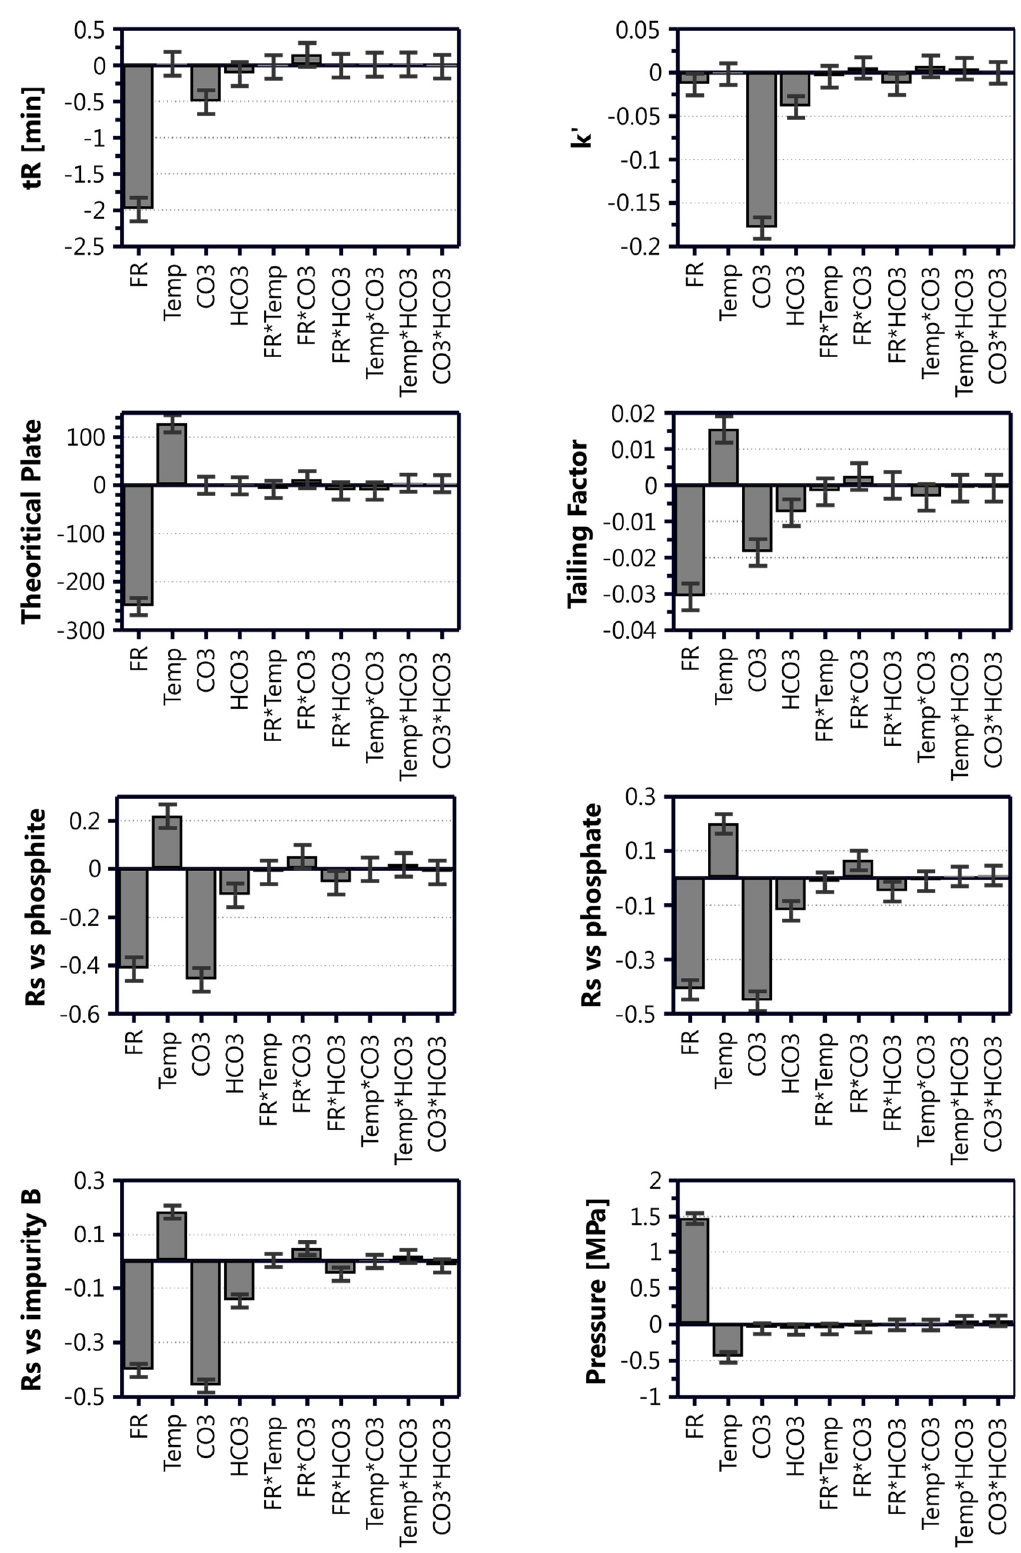
Figure 3. Coefficient plots for the full factorial design modeled around the provisionally optimum method conditions. The boxes indicate the relative impact of the coefficient on the model, while the whiskers show the uncertainty of the coefficient value, and consequently, if the uncertainty exceeds the value, that coefficient will be considered insignificant. The star (*) indicates interaction terms between different variables.